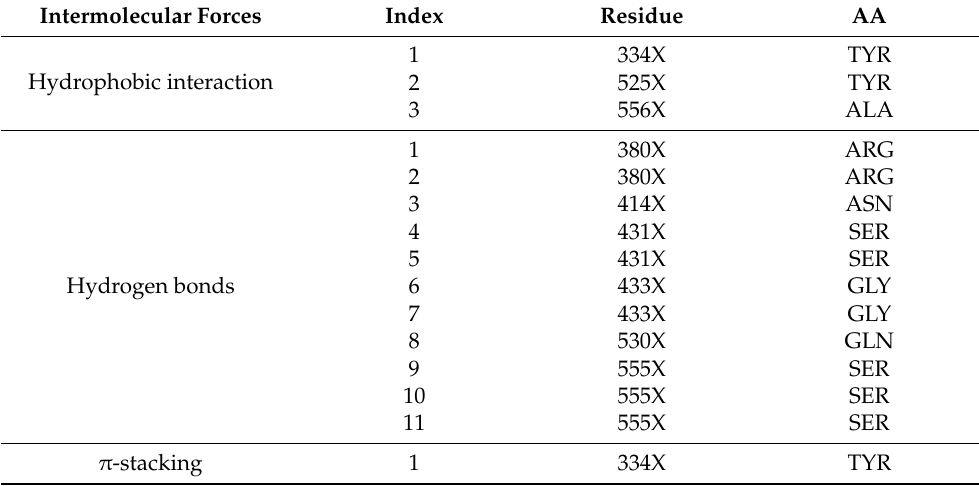
Table 4. Interaction force and the P6 binding site with the Keap1 active site (PDB ID: 2FLU). Intermolecular